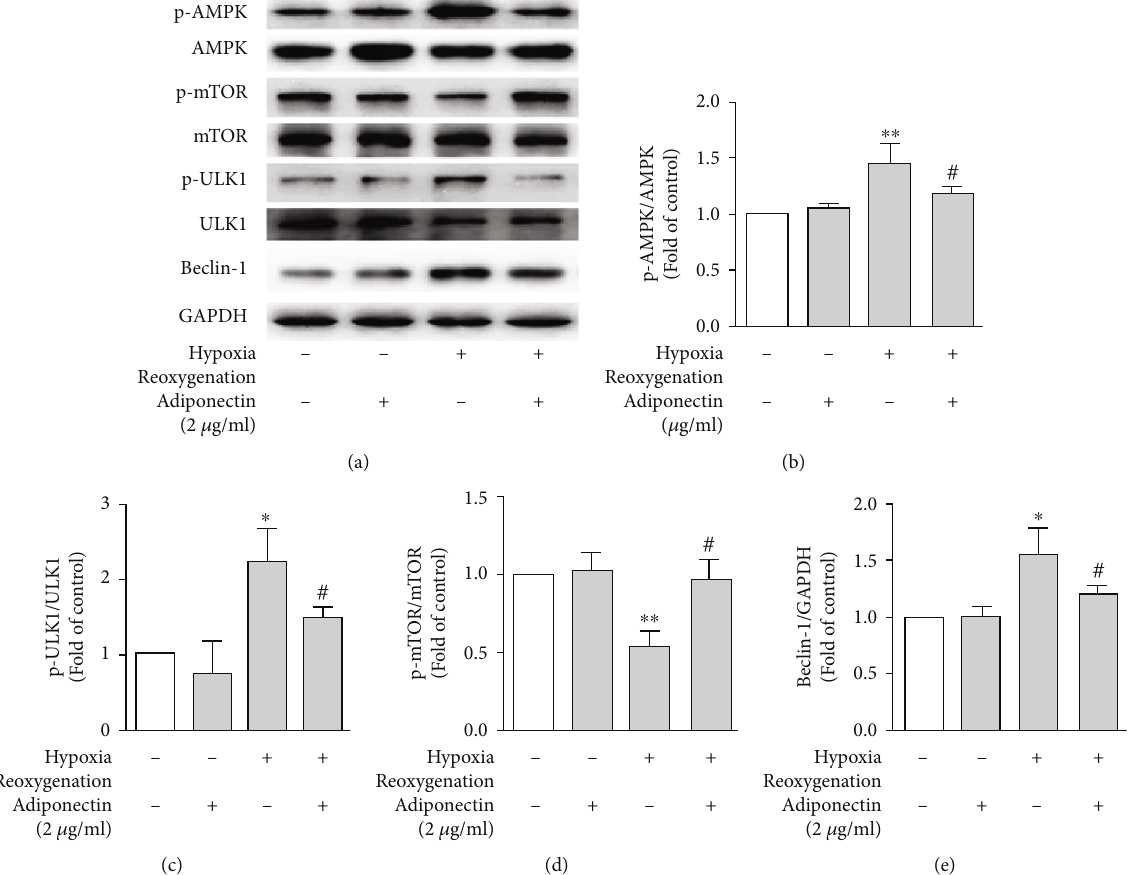
Figure 4: Adiponectin treatment counteracts hypoxia/reoxygenation-induced AMPK activation and downstream signaling in cardiomyocytes. Neonate rat cardiomyocytes were cultured at normoxia condition (control group) or underwent hypoxia/reoxygenation exposure in the presence of adiponectin (2 μ g/ml) or vehicle. (a) Representative western blot images showing the total and phosphorylated form of AMPK, mTOR, and ULK11 as well as Beclin-1 protein. (b – e) Quanti fi cation of phosphorylated AMPK (b), ULK1 (c), and mTOR (d) as well as Beclin-1 protein levels. Phosphorylated levels of individual proteins were presented as the fold changes relative to that in vehicle-treated cells cultured at normoxia condition (control group). All data are mean and standard error mean ( n = 4 ). Two-way ANOVA followed by two group comparison. ∗ P < 0 : 05 and ∗∗ P < 0 : 01 compared to control group; # P < 0 : 05 compared to hypoxia/reoxygenation